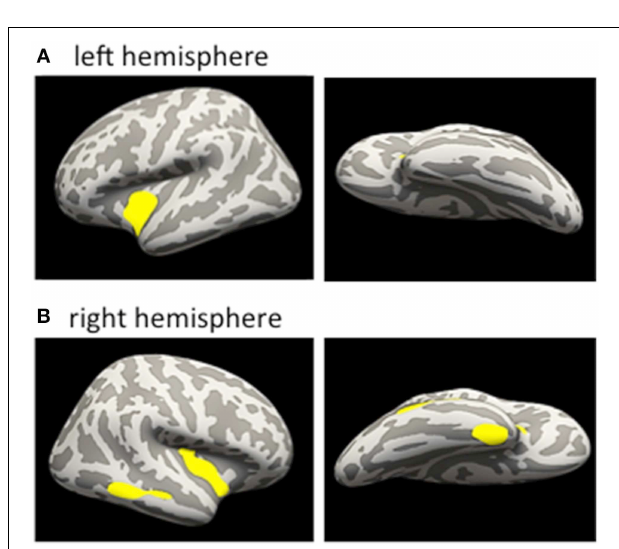
FIGURE 3 | Correlational analyses between number of mTBI and CT within the mTBI group. Inflated brain. Clusters reveal negative correlation between number of mTBI and CT; (A) left hemisphere, correlation within the mTBI group; (B) right hemisphere, correlation within the mTBI group; for details see text. No positive correlations were found. mTBI, mild traumatic brain injury; CT, cortical thickness.